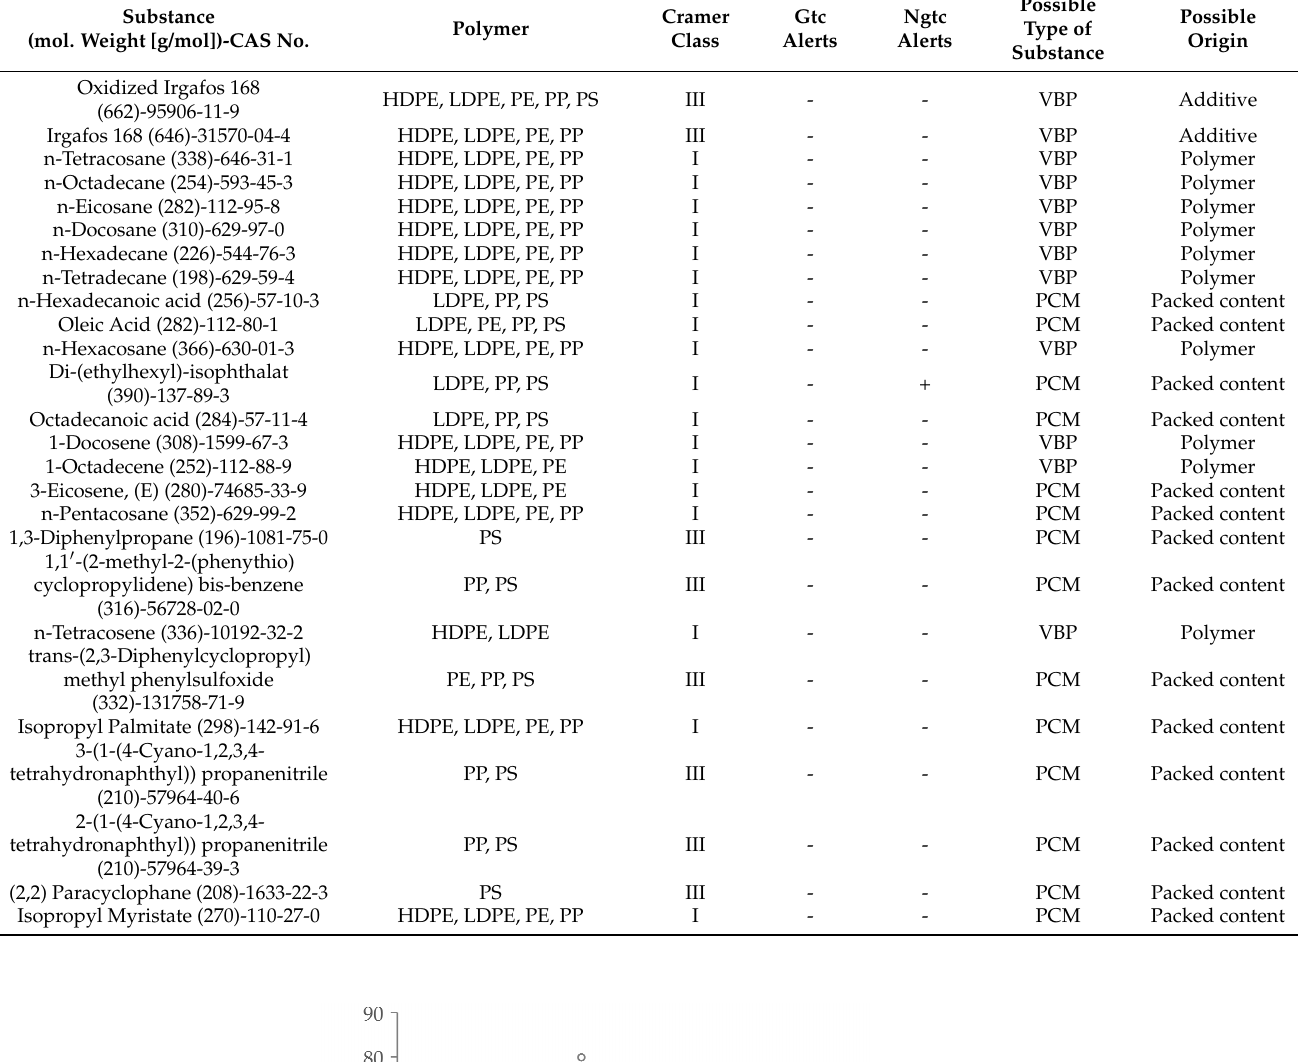
Table 3. Most frequently detected substances with information about the respective polymers they were detected in, toxicological parameters (Cramer classification, gtc and ngtc alerts), possible origin, and type of substances with virgin base polymer substances (VBP) and post-consumer material substances (PCM).